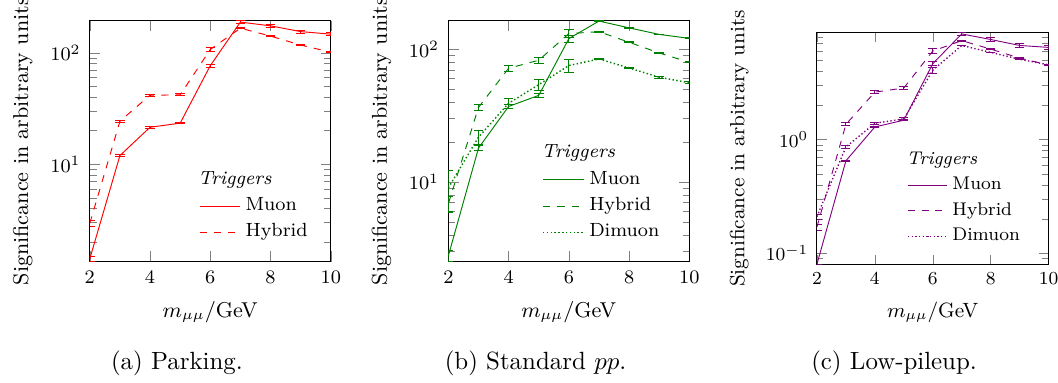
Figure 7 : Comparison of the significance to discover the displaced low- p as a function of the dimuon invariant mass. The comparison is shown for three of the five datasets: parking (a), standard pp (b), and low-pileup (c) for the three different triggers scenarios during Run 3. Since only the dimuon trigger applies to the scouting and heavy ion dataset, we omit these datasets